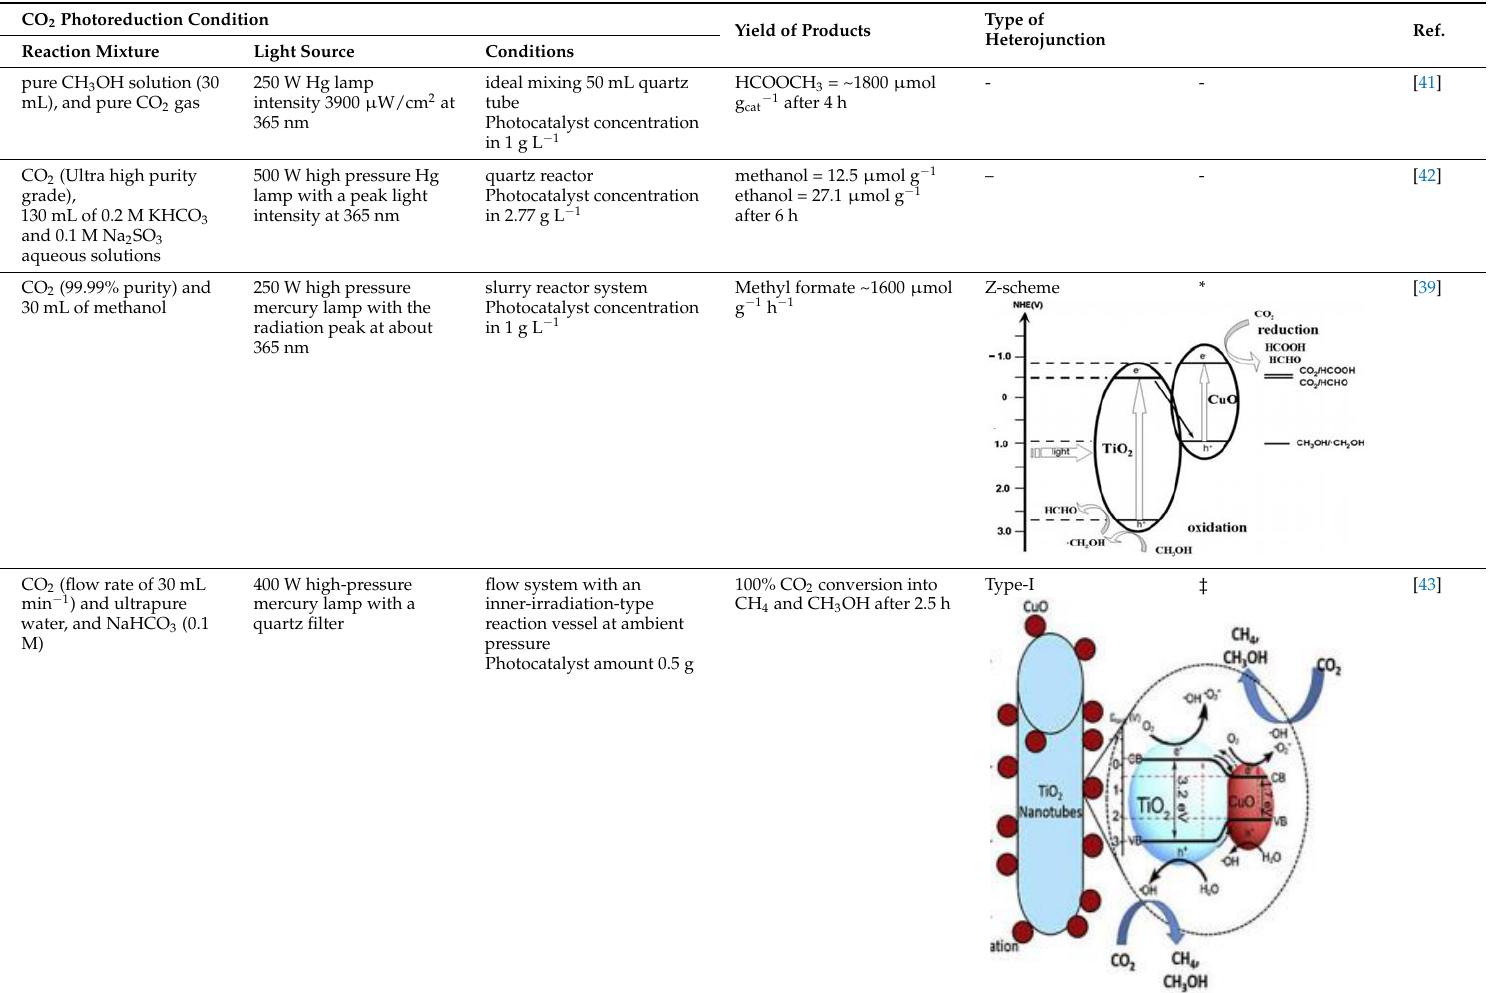
Table 4. CO 2 photoreduction using CuO/TiO 2 heterojunction photocatalysts.